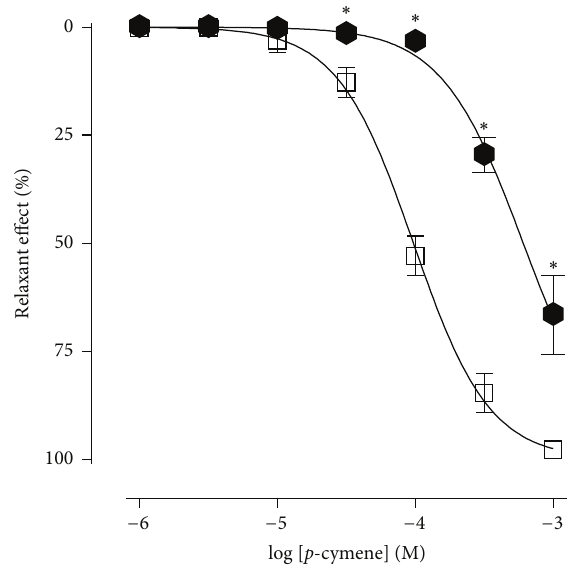
Figure 5: Relaxant effect of p -cymene on the isolated rat aortic rings without endothelium, contracted by phenylephrine, in the absence ( ◻ ) and presence of TEA 1mM ( 󳵳 ), TEA 10mM ( △ ), or 4-AP 3 mM ( 󳶃 ).